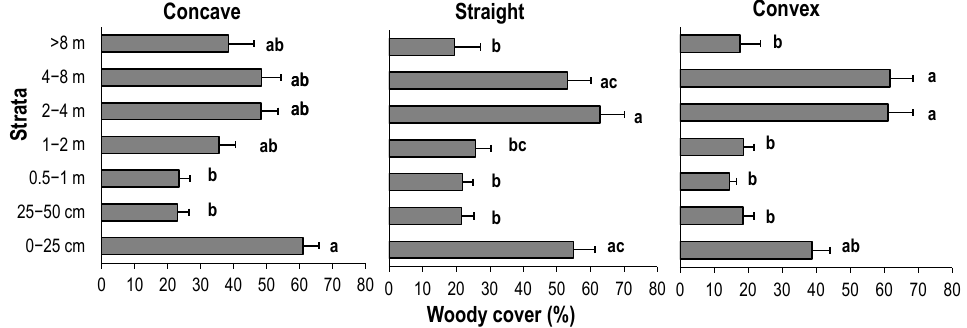
Figure 1. Vertical structure of woody vegetation in the forest edge next to the mine (mean cover and standard error in each stratum) according to the boundary form (concave, straight, or convex). Different letters indicate significant differences between all pairwise comparisons with Bonferroni’s test ( p < 0.05); i.e., among strata within each boundary form, and among boundary forms for each stratum.